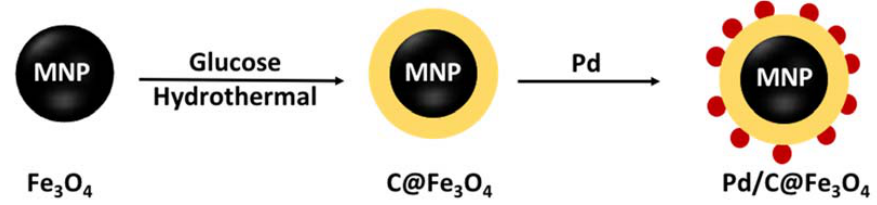
Figure 9. Schematic illustration of synthesis steps for C@Fe 3 O 4 core ‐ shell nano ‐ spheres [66] (Adapted with permission from Elsevier).